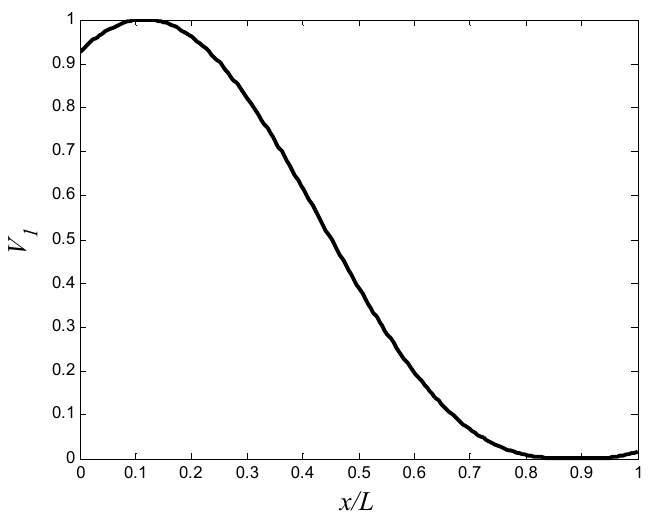
Figure 6. The optimal aluminum volume fraction profile which maximizes the gap between f 1 and f 2 (control points approach).